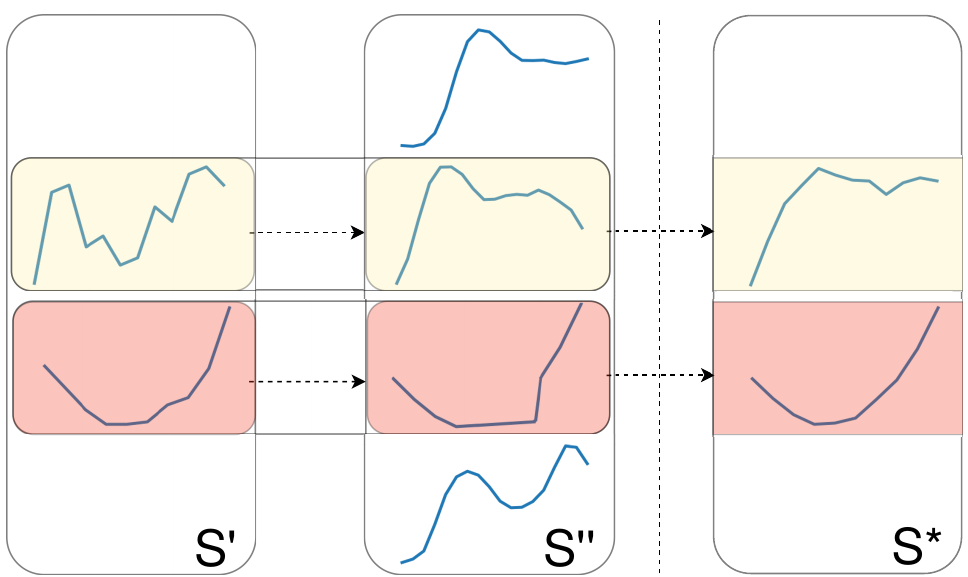
Figure 5. An example of the shapelet merging crossover